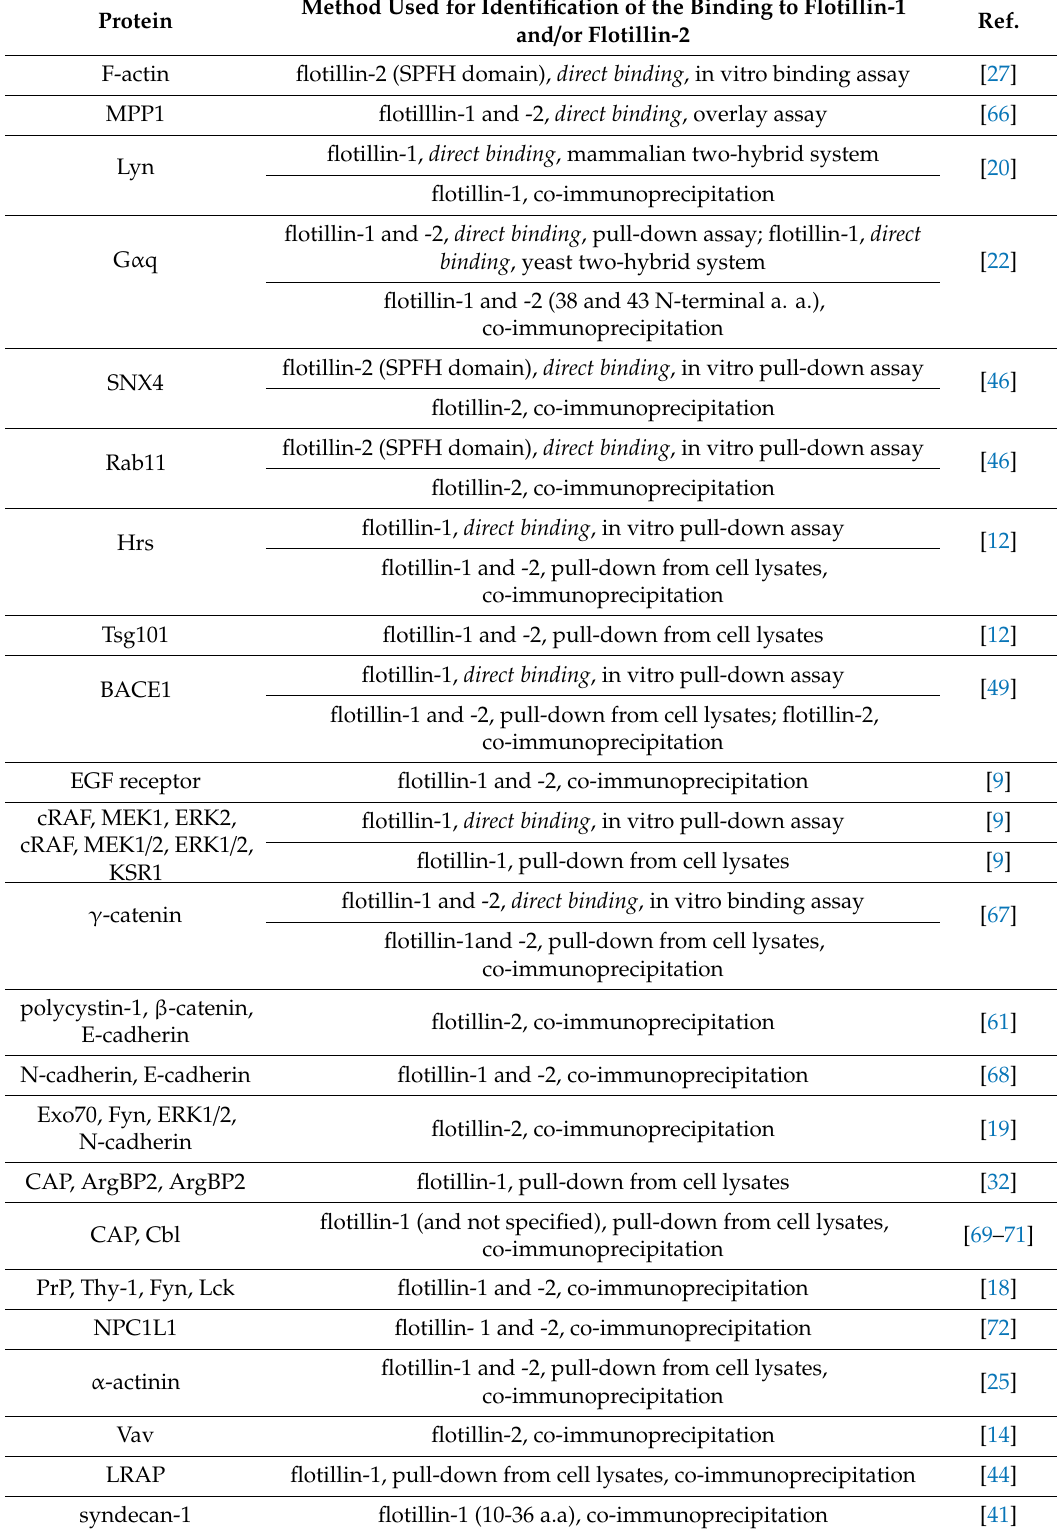
Table 2. Flotillins and their protein